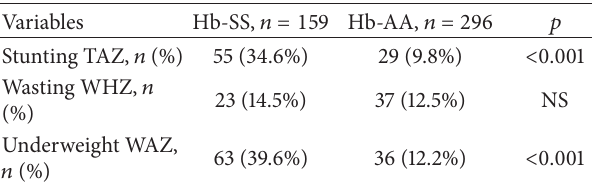
Table 3: Nutritional status according to Hb status in children under 12 years of age in the study